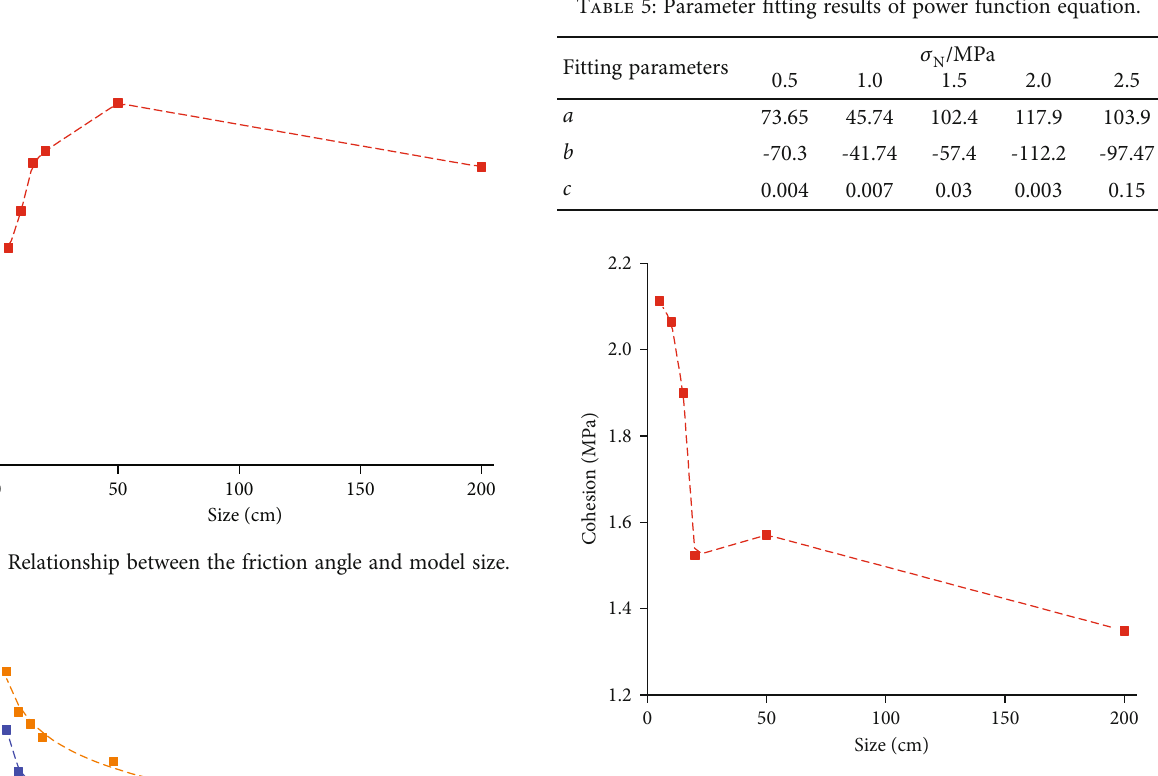
Figure 10: Relationship between cohesion and model size.